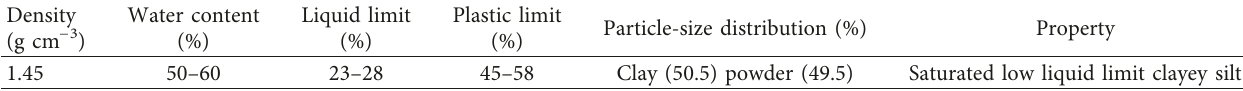
Table 1: The properties of dredged sea mud.